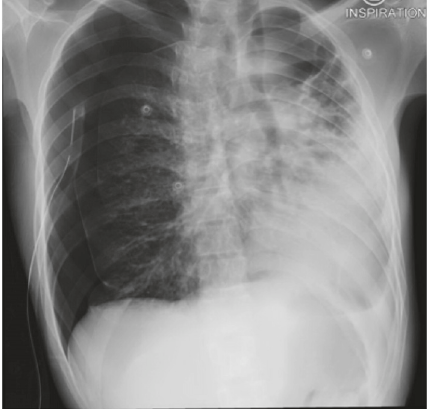
Figure 3: Chest X-ray showing worsening of the pneumothorax despite presence of a chest tube.